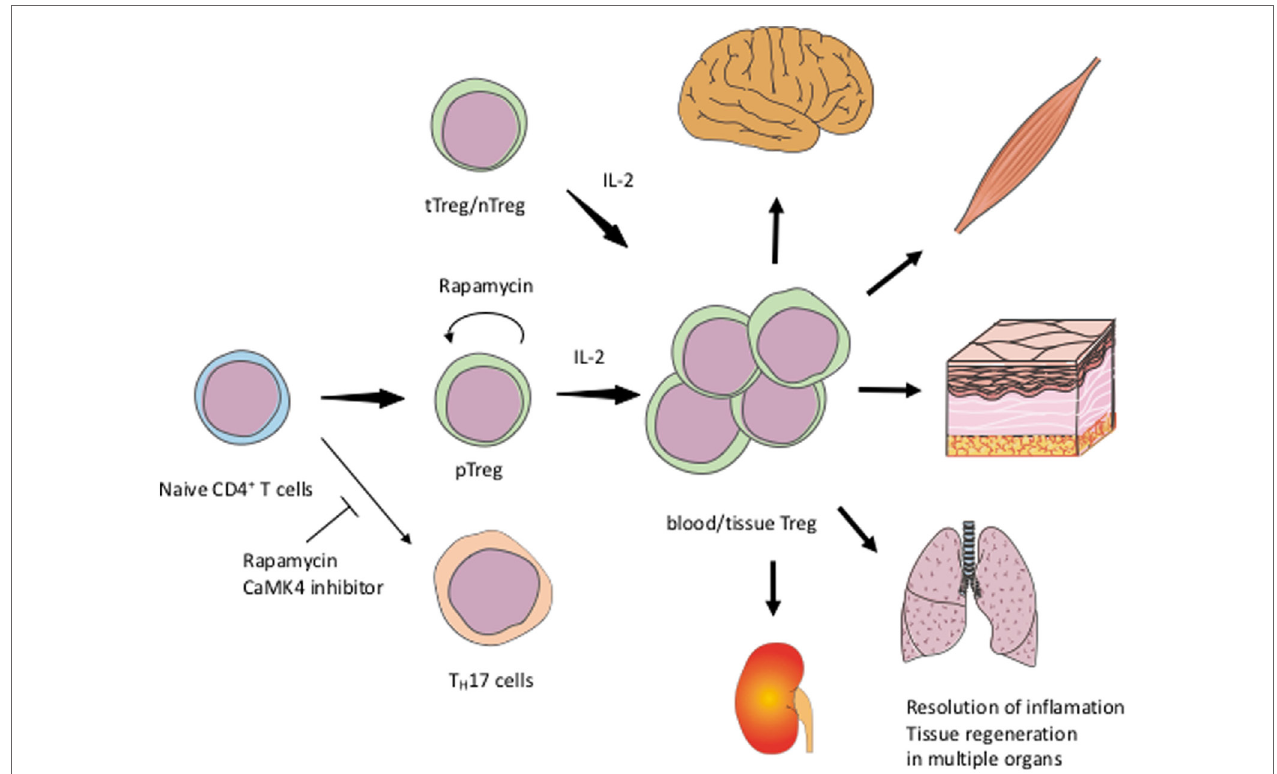
FiGURe 1 | Schematic view of exploiting Tregs for the treatment of SLEIL-2 expands both tTreg/nTreg and pTreg including tissue Treg. Rapamycin and CaMK4 inhibitor facilitate the differentiation of Treg and inhibit T H 17. Rapamycin can also stabilize the Treg function. tTreg, thymic regulatory T-cells; nTreg, naïve Treg; pTreg, peripheral Treg; T H 17, IL-17-producing helper